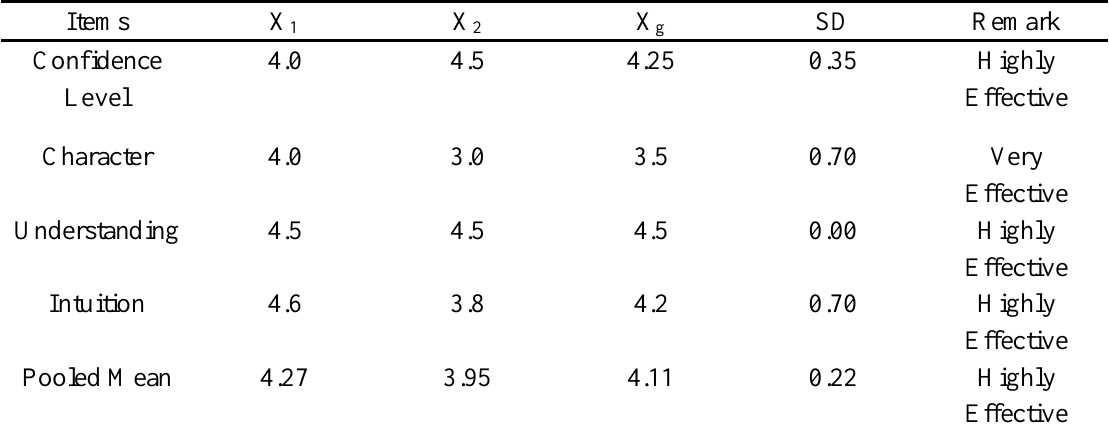
Mean rating on how effective early childhood development is to family restiveness